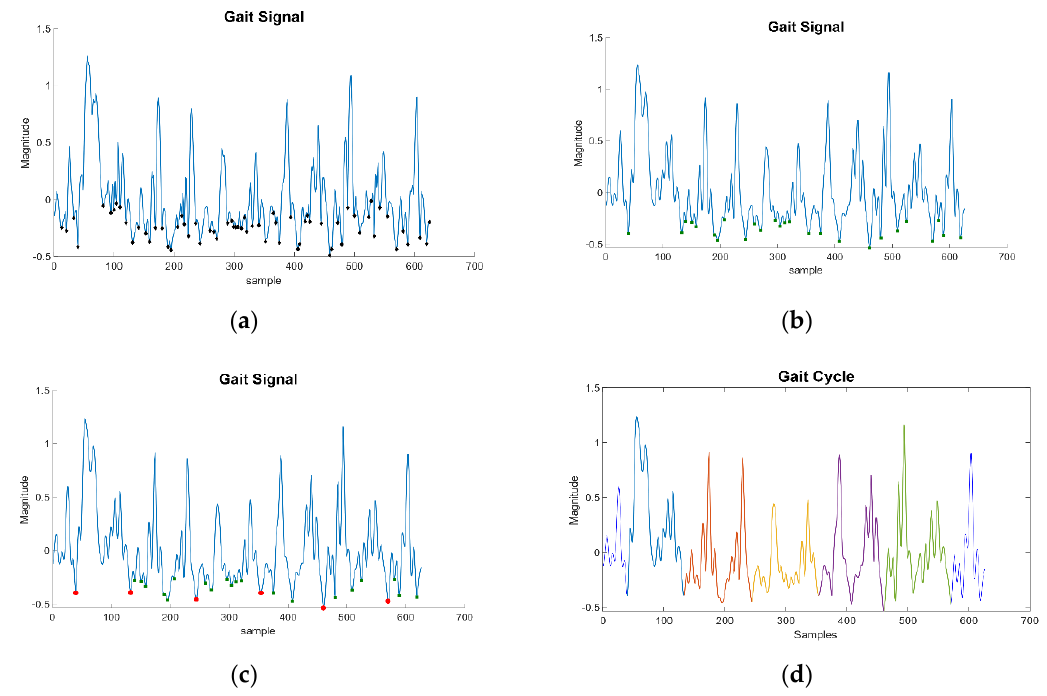
Figure 3. Cycle extraction process. ( a ) local minima, ( b ) magnitude remaining, ( c ) delimiting starting cycles, ( d ) final cycles (differentiated by colors).